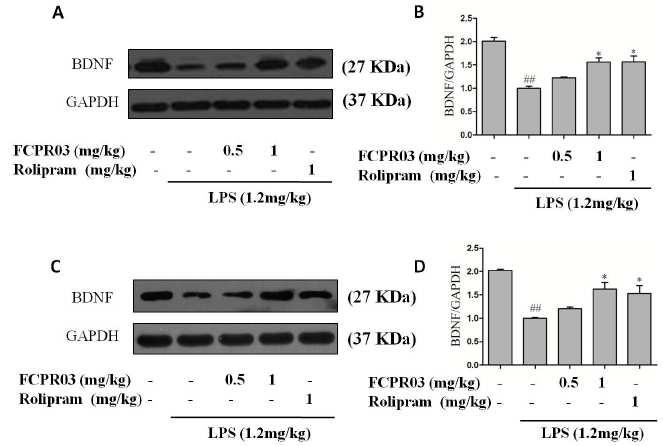
Figure 6. FCPR03 enhanced the level of BDNF in both cortex and hippocampus in mice challenged with LPS. After seven consecutive days of pretreatment with FCPR03 (0.5 mg/kg or 1 mg/kg) or rolipram (1 mg/kg), mice were injected i.p. with saline or LPS (1.2 mg/kg, i.p.); 24 h after LPS injection, the entire hippocampal and cortical extracts were homogenized, and Western blot was used to assess BDNF protein levels in the cortex ( A ) and hippocampus ( C ). The corresponding quantification data are shown in ( B , D ). Data are expressed as the mean ± SEM. ## p < 0.01 compared with control group; * p < 0.05 compared with LPS-treated group ( n = 8 per group).